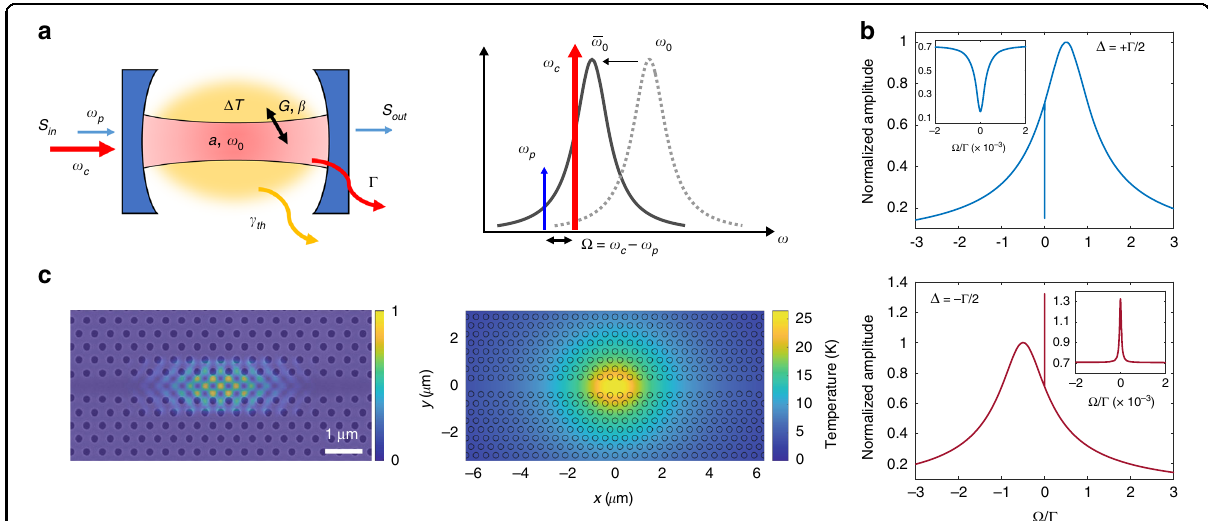
Fig. 1 Control-probe of a thermo-optical cavity. a (left) Schematic of the thermo-optical cavity, showing the fi elds and the main physical quantities involved. (right) Thermo-optically shifted resonance (blue-detuning regime) as a static effect of the control fi eld. b Calculated pump-probe response from the steady state solution of the equations of motion, showing the output power oscillation amplitude ~ I probe detuning frequency Ω , in the ampli fi cation (red pump-cavity detuning, bottom) and absorption (blue pump-cavity detuning, top) regimes, respectively. The broad resonance represents the bare cavity mode, while the narrow spectral feature (inset) at zero pump-probe detuning is due to the thermo-optical nonlinearity. c (left) Scanning electron micrograph and simulated optical fi eld intensity distribution (normalized) of the photonic crystal cavity used for the experiment. The optical mode localizes at the widest point of the line-defect. (right) Simulated thermal distribution for a stationary absorbed power P abs = 1 mW in correspondence of the cavity